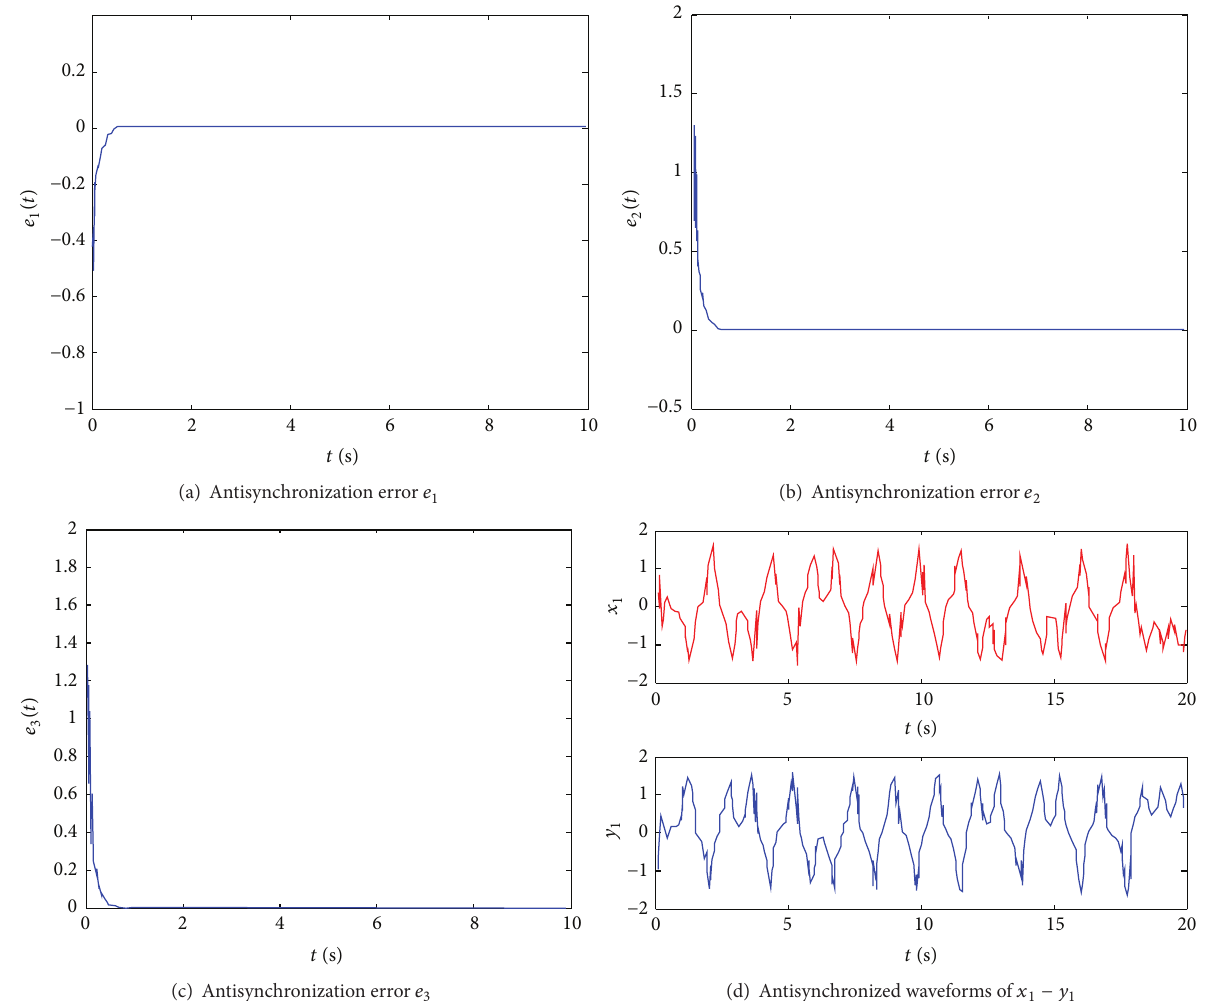
Figure 3: Antisynchronization error curves and waveforms of active